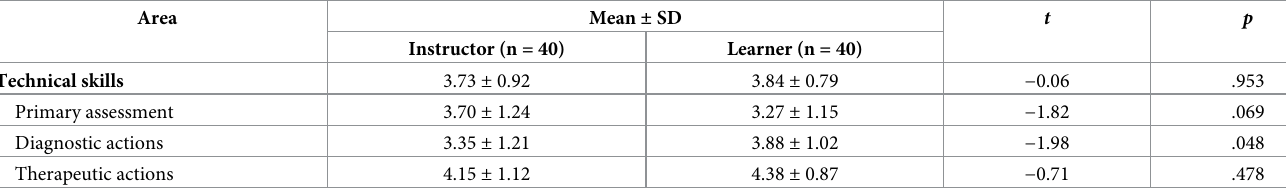
Table 3. Differences between the evaluations of technical skills of the instructor and